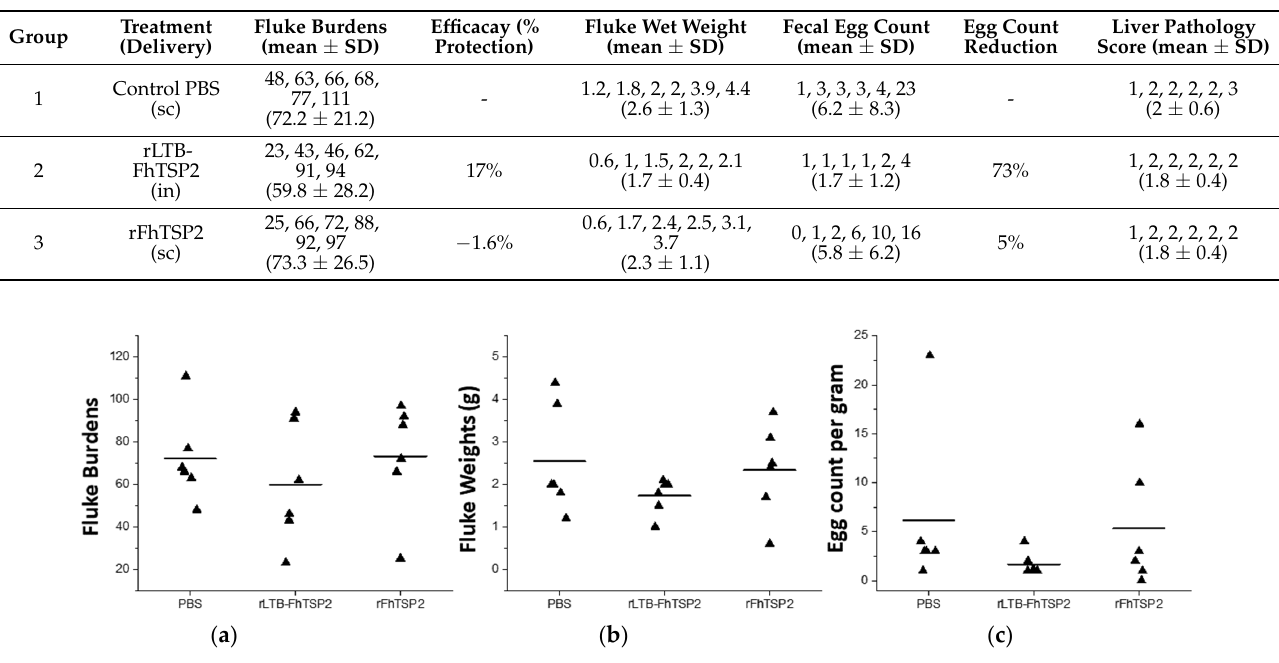
Figure 5. Liver fluke infection parameters for each vaccination group. ( a ) Liver fluke burdens, ( b ) fluke wet weights, and ( c ) faecal egg counts for each group. PBS: infection control vaccinated with PBS, rLTB ‐ FhTSP2: intranasal vaccination with rLTB ‐ FhTSP2; rFhTSP2: subcutaneous vaccination with rFhTSP2. Each animal is denoted as a black triangle and the mean fluke burden for each group is represented by a solid line.